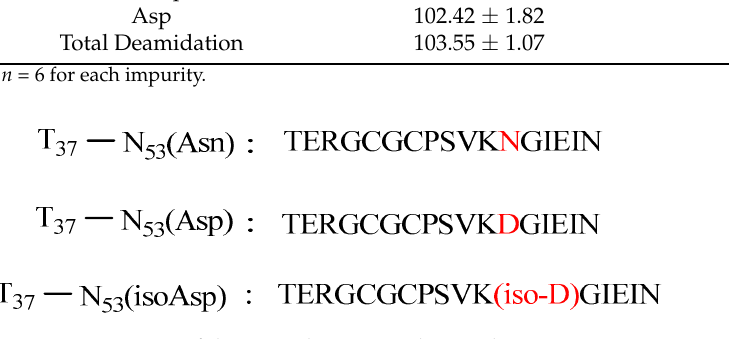
Figure 5. Sequence of three synthetic peptides used to measure recovery. Table 4. Calculated recoveries a .